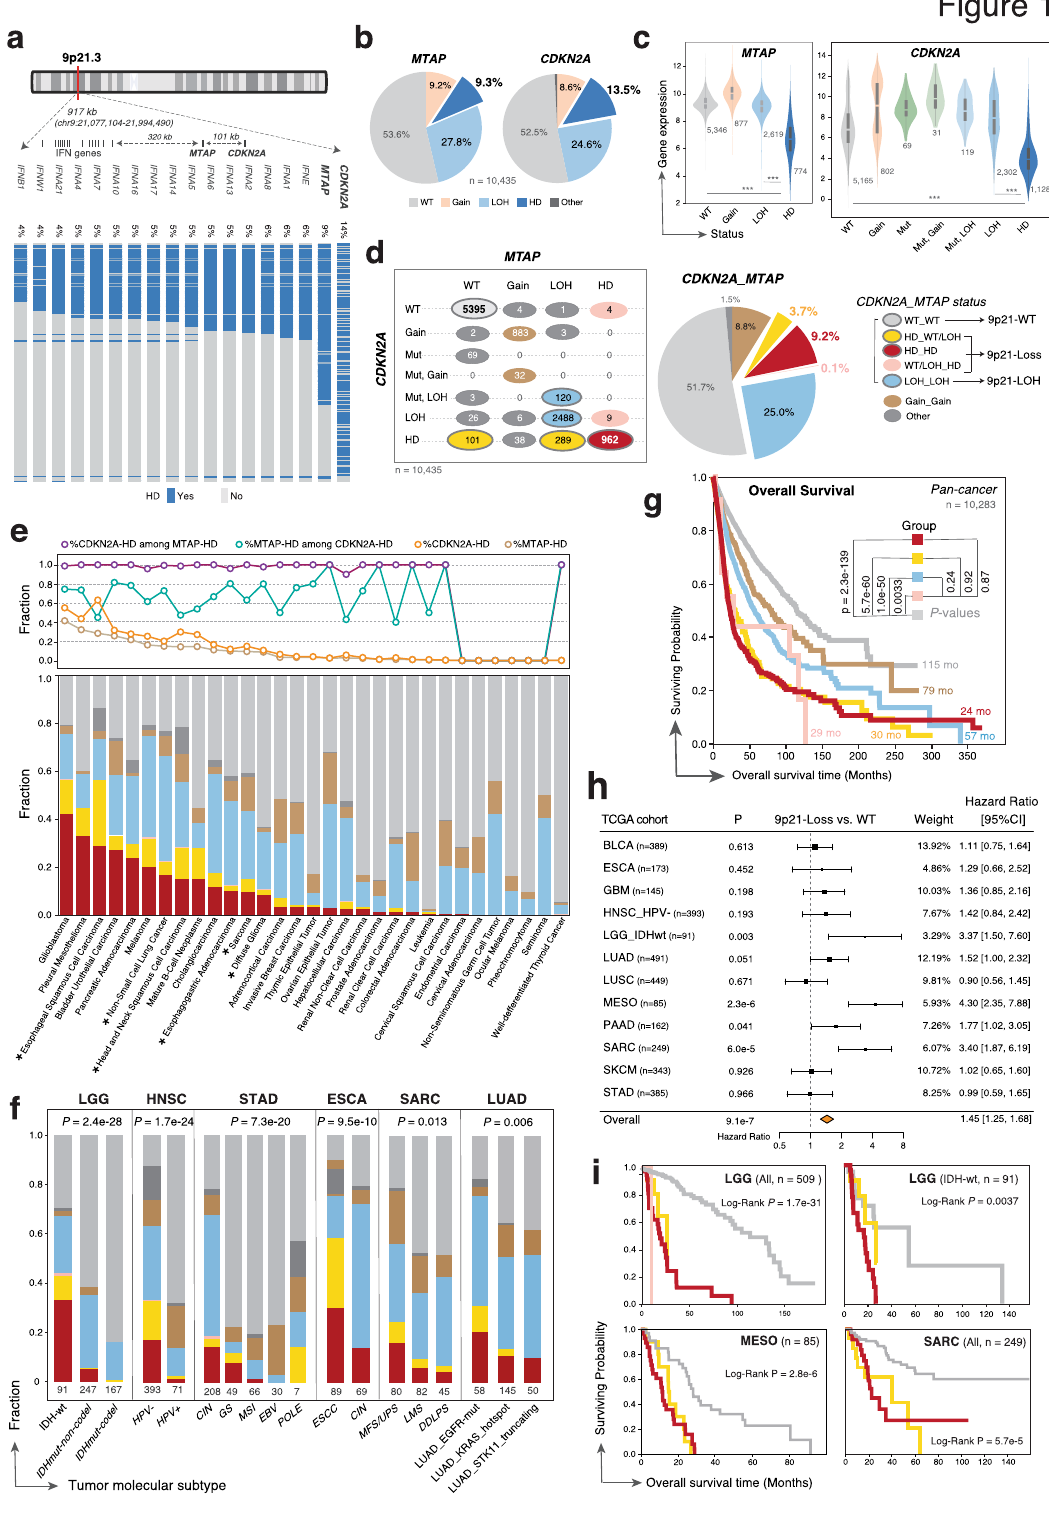
(SKCM), bladder (BLCA), pancreatic (PAAD) and gastric (STAD) cancer, lung adeno- (LUAD), and squamous-cell carci- noma (LUSC)] that had frequent 9p21 loss (>10%). Overall, we observed decreased density of TILs (fewer TIL patches) in 9p21- loss tumors compared to 9p21-WT tumors. For example, there was a trend towards decreased proportion of the “ brisk diffuse ” structural pattern (with diffusely in fi ltrative TILs scattered